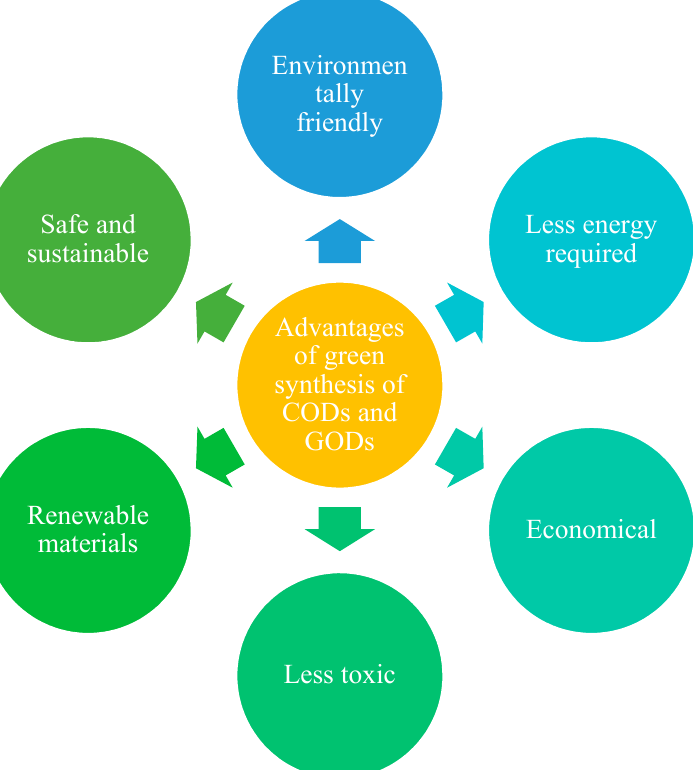
Figure 4. Advantages of green synthesis of CODs and GODs.